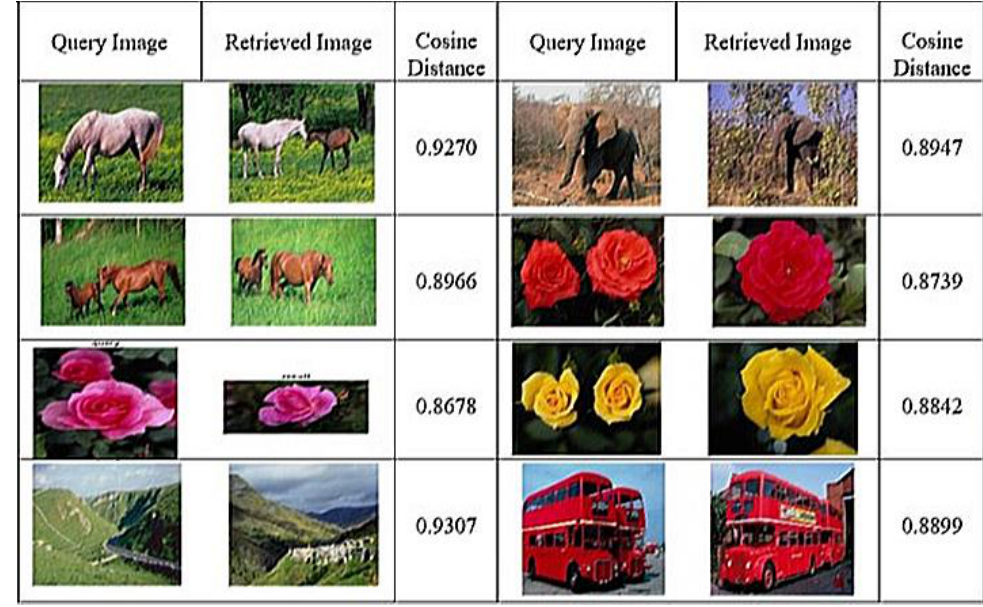
Figure 13. Results on WANG 1000 images.